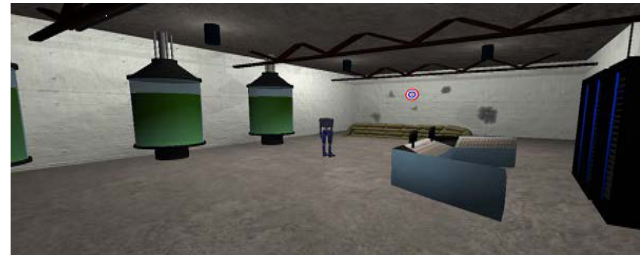
Figure 7. Gameplay area in Unity, as well as the character standing in the middle of the